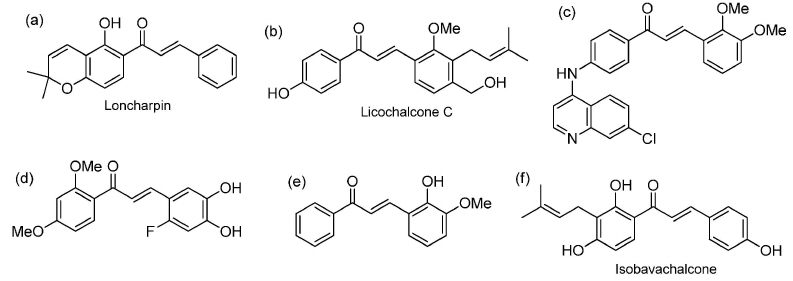
Figure 1. Examples of chalcone derivatives with various biological effects: ( a ) antiplatelet activity [8]; ( b ) antibacterial activity [6]; ( c ) antitubercular activity [9]; ( d ) anti-inflammatory effect [7]; ( e ) antiviral